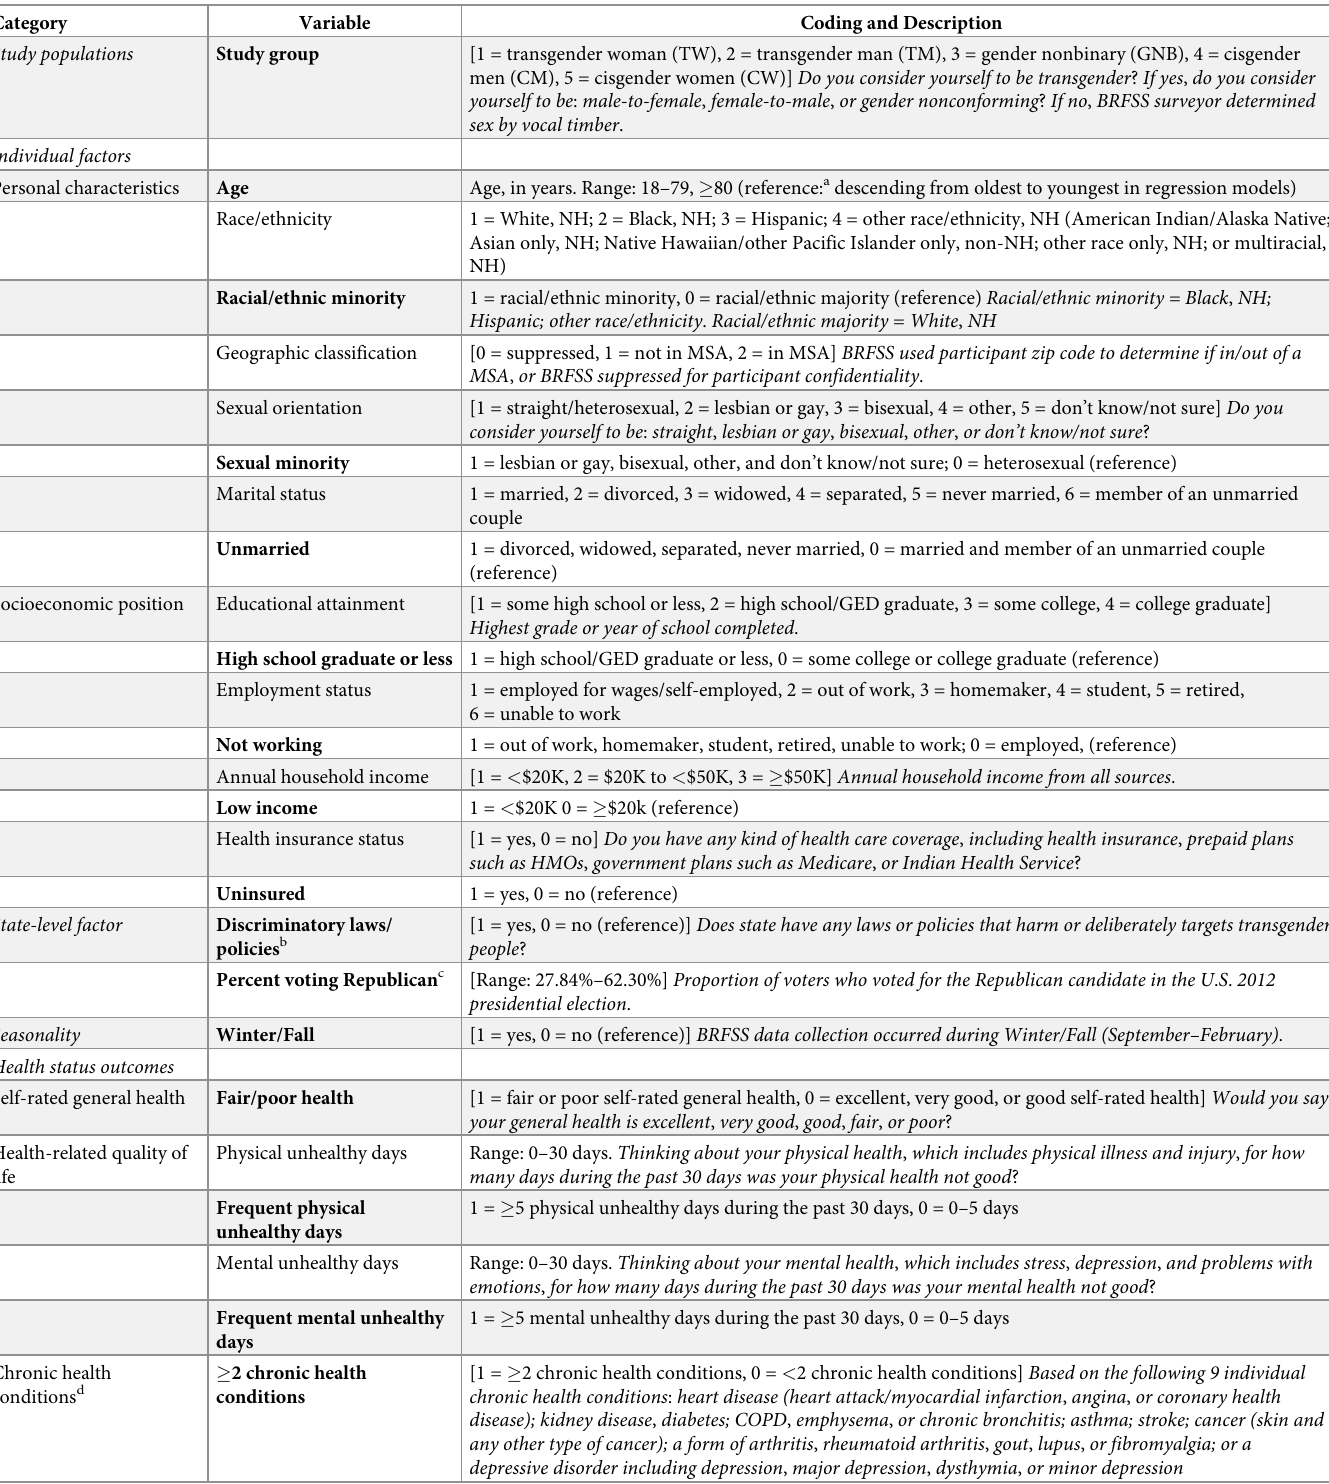
Table 1. Coding and description for study variables: Study populations, individual and state-level factors, seasonality, and health status outcomes.